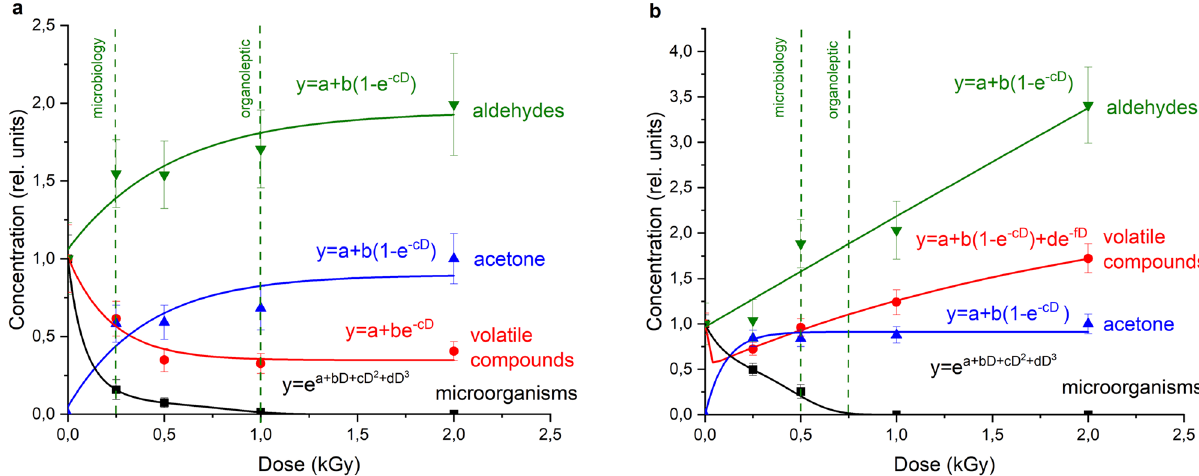
Figure 7. Dose dependence of the change in the relative concentration of volatile compounds (red curve), acetone (blue curve), aldehydes (green curve) and microorganisms (black curve) in turkey meat after treatment with ( a ) electron and ( b )